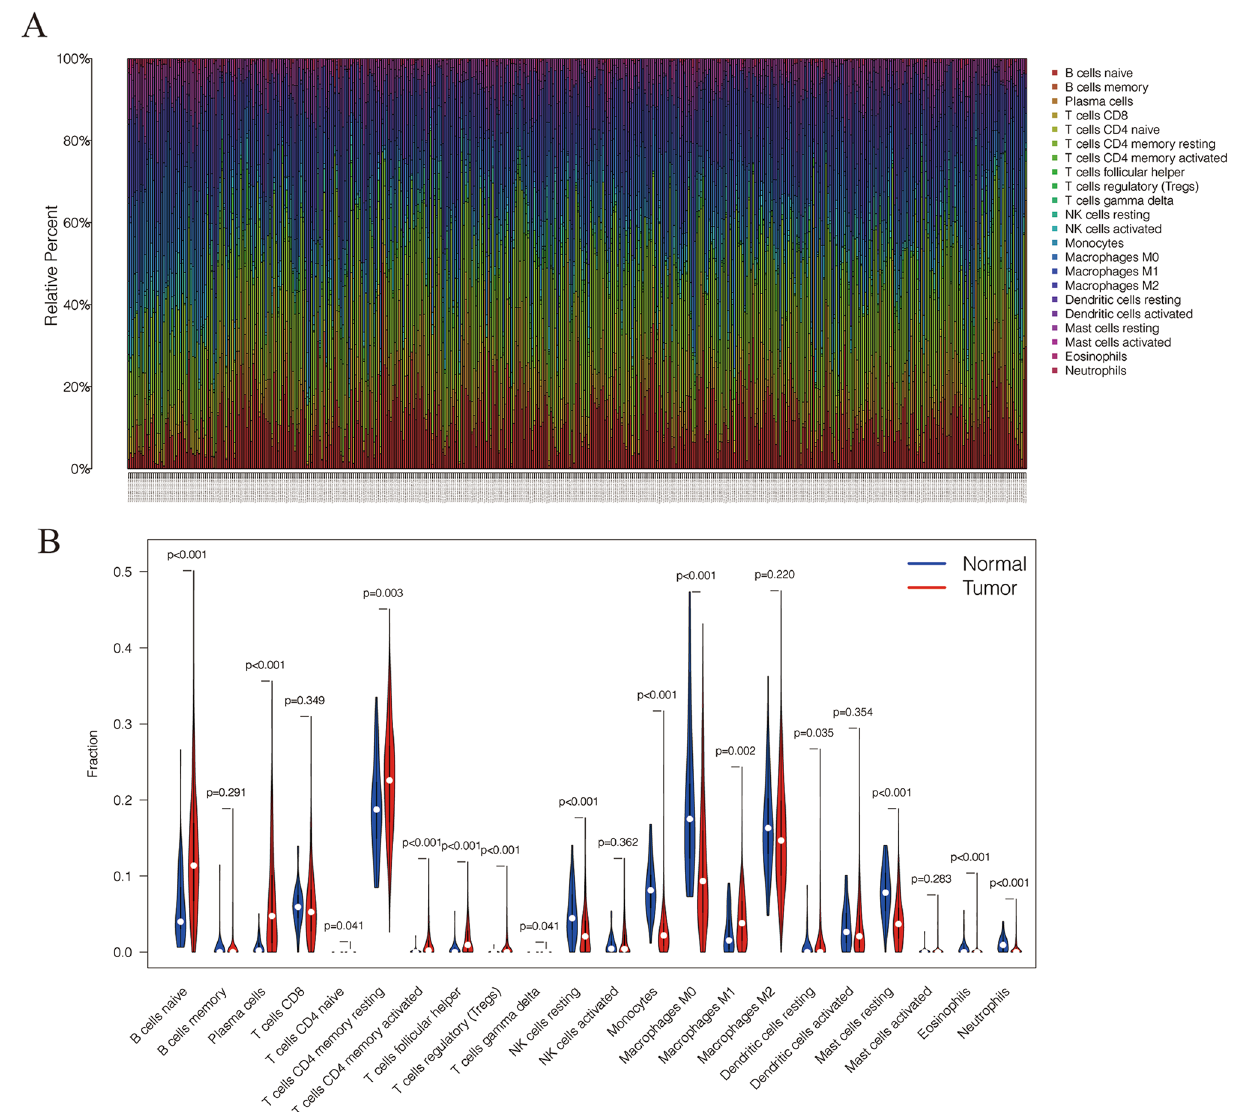
Figure 6. The composition of immune cells in lung adenocarcinoma. ( A ) The component of immune cells in the TCGA-LUAD cases. ( B ) The violin plot shows the levels of immune cells in the tumor group (red) and the normal tissue group